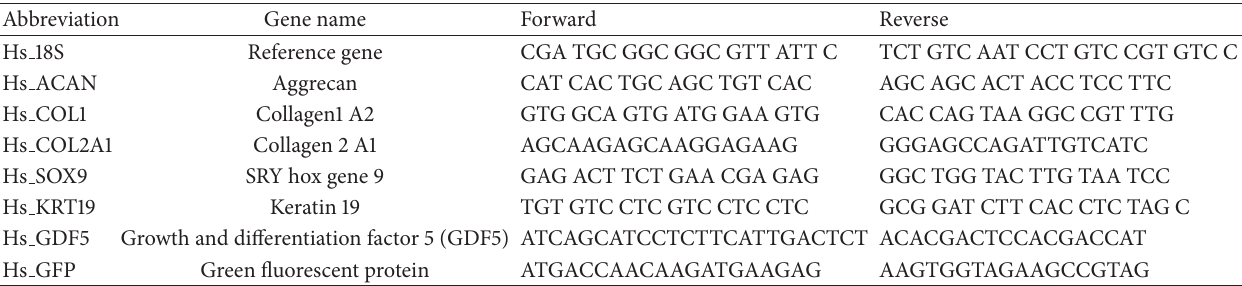
Table 2: Primer list used for